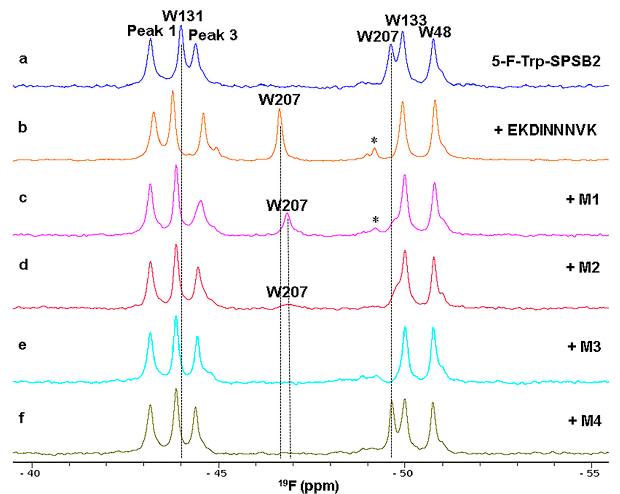
Figure 2. 19 F-NMR spectra of 5-F-Trp-SPSB2 in the absence and presence of peptidomimetics M1 , M2 , M3 and M4 . Chemical structures of M1 – M4 are shown in Figure S1. The peptide EKDINNNVK was included as a control. Each experiment contains 50 μ M of 5-F-Trp-SPSB2 in the presence of either 9-residue long DINNN-containing peptide or mimetic at a SPSB2: peptide/mimetic molar ratio of 1:1.5. All six 5-F-Trp residues in SPSB2 were observed in the 19 F-NMR spectrum. Most 5-F-Trp resonances (W48, W131, W133 and W207) were assigned except the completely buried Trp residues, W91 and W95 [31], which are labelled as peaks 1 and 3. The W207 resonance was significantly perturbed by both the peptide and the mimetics. In some instances, the presence of mimetic (e.g., M1 – M3 ) caused the appearance of some minor peaks, which appear to be minor conformers of peak 3 and W48. The peaks marked with asterisks are from denatured protein; all six 5-F-Trp resonances converged to a single peak at − 49.2 ppm when the temperature was raised to 50 °C. 19 F-NMR spectra were recorded at 30 °C in 50 mM sodium phosphate, pH 7.4, 50 mM NaCl, 2 mM DTT, 2 mM EDTA, 0.02% sodium azide at 564 MHz on a Bruker Avance 600 spectrometer equipped with a cryoprobe tuned to 19 F and without 1 H decoupling.